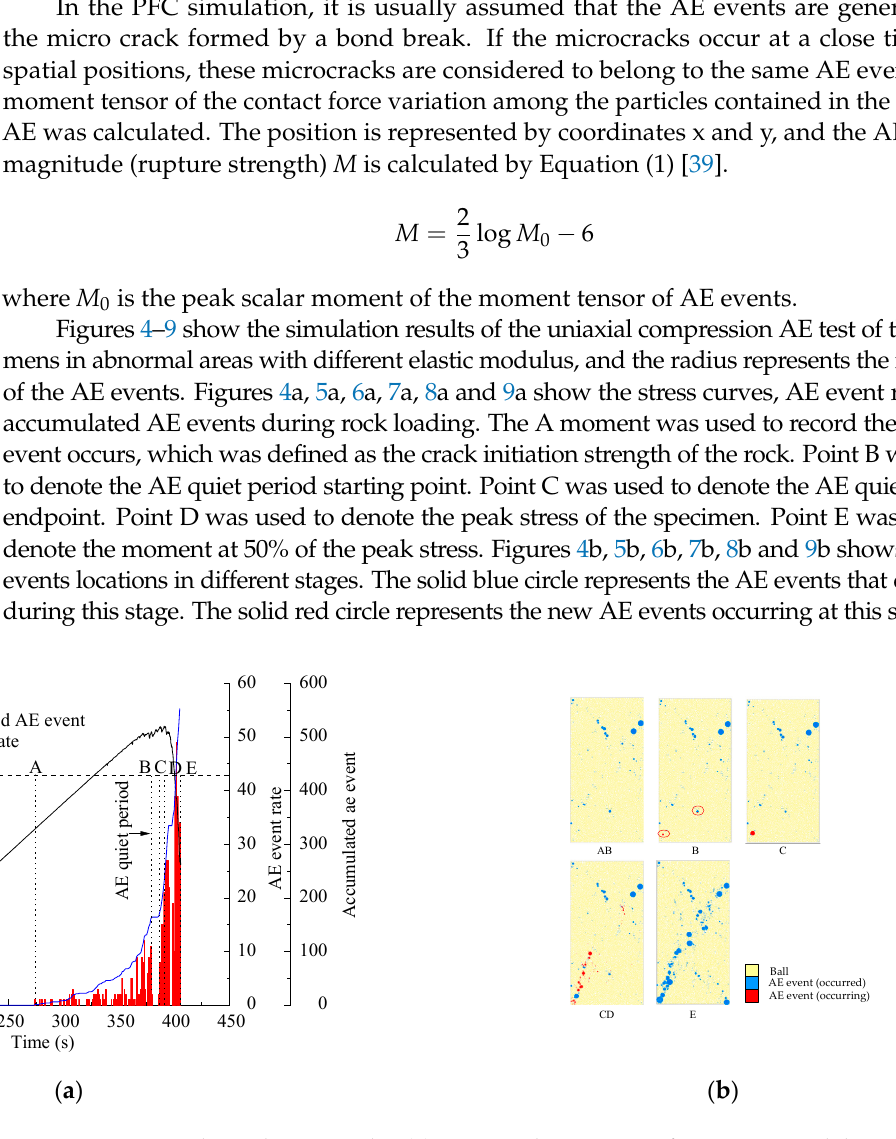
Figure 5. Numerical simulation results. ( a ) Stress and AE events of specimens with abnormal elastic modulus of 40 GPa; ( b ) AE events distribution at different stages of the specimen.